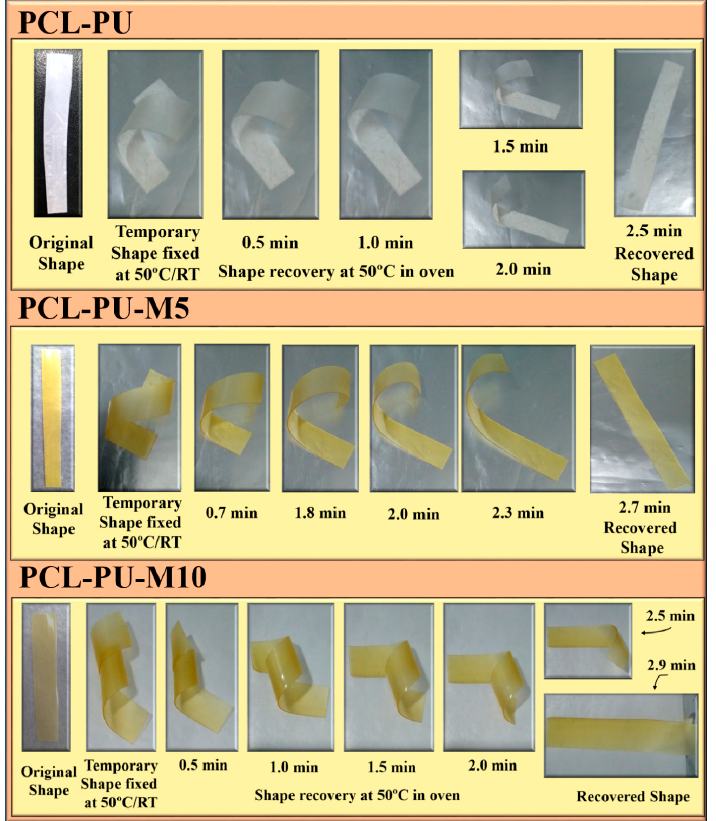
Figure 9. Demonstration of the shape memory effect in the PCL-PU-Chitosan biocomposite in a dry condition.